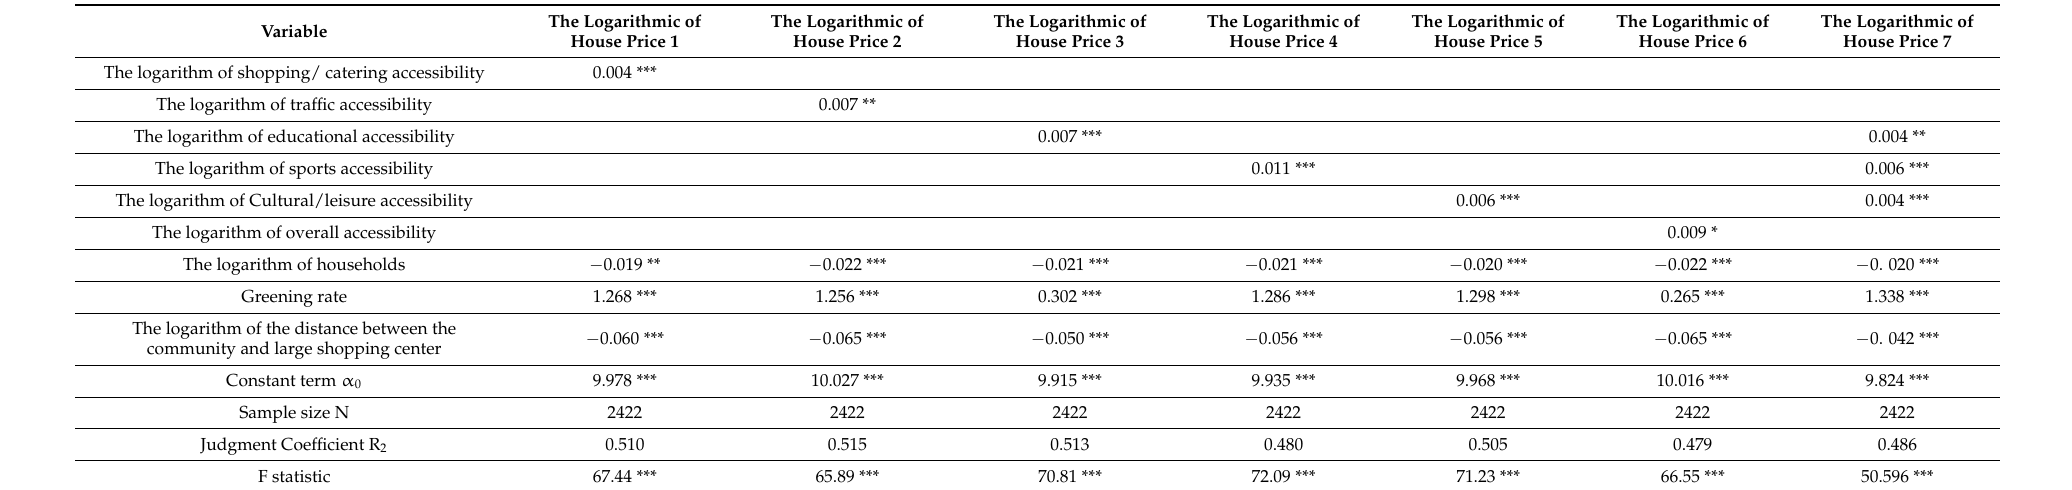
Table 4. Impacts of public service facility accessibility on housing